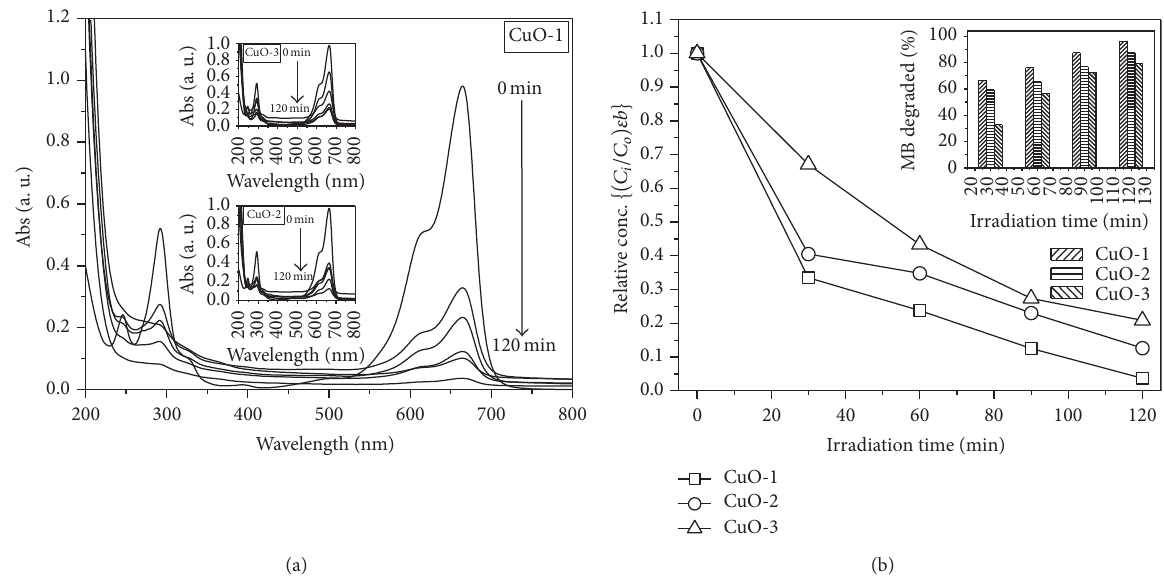
Figure 4: (a) Absorption spectra with time of MB dye solution irradiated in presence of CuO-1 photocatalyst; inset is the absorption spectra of MB dye solution irradiated in presence of photocatalysts CuO-2 and CuO-3 and (b) plots of relative conc. versus irradiation time; inset is the percent MB dye degraded as a function of irradiation